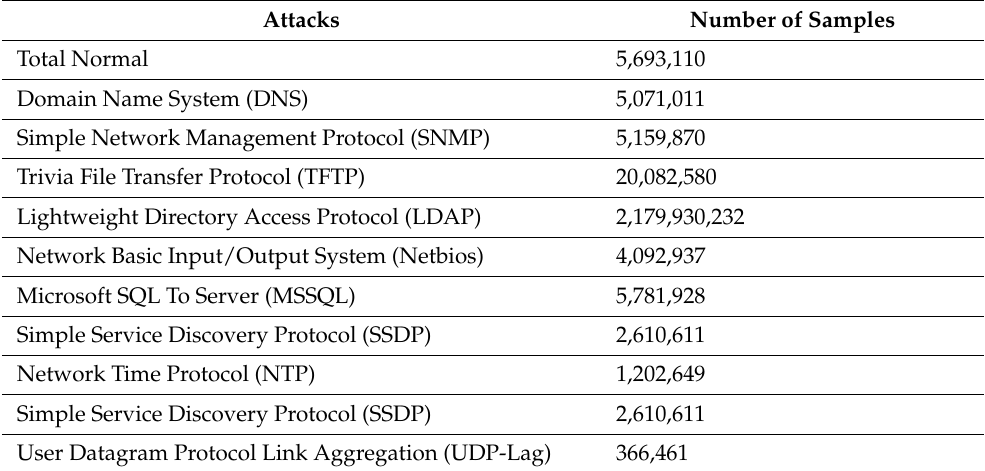
Table 1. List of Attacks.